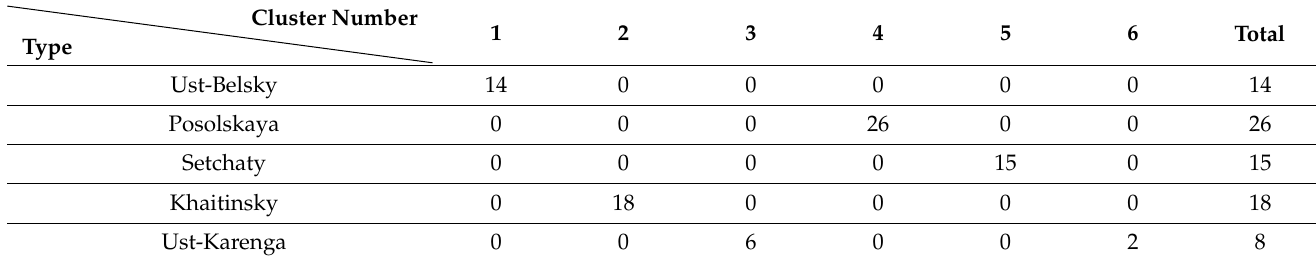
Table 3. Frequency table for cluster analysis of ceramic samples characterized by type.